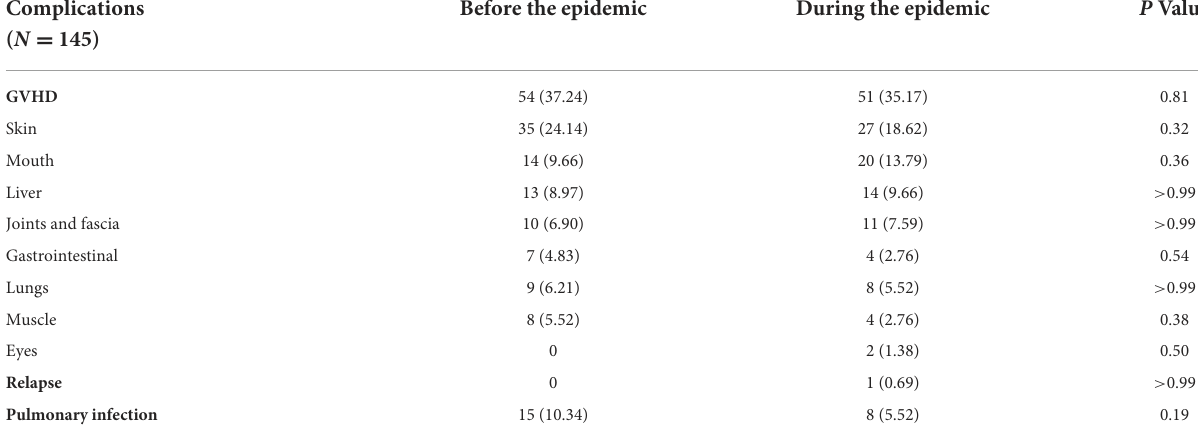
TABLE 2 HSCT complications of HSCT recipients during the COVID-19 epidemic.